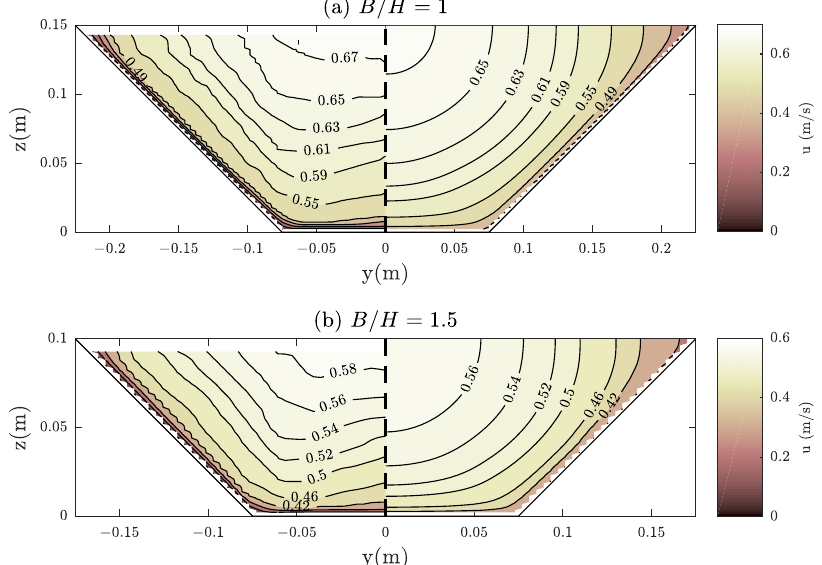
Figure 8. Comparison of calculated (right) and measured (left) streamwise velocity distribution in trapezoidal channels of the experiments of Yuen [35]: ( a ) B / H = 1; and ( b ) B / H =